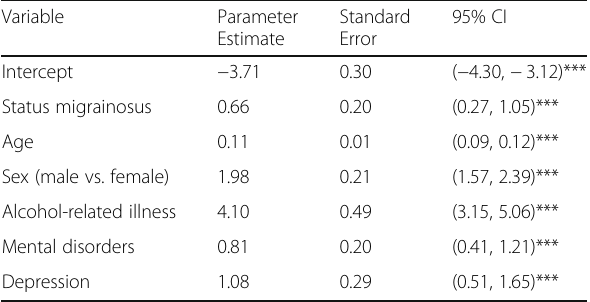
Table 4 Stepwise regression analysis for average hospital days per year (all-cause admission) among patients with migraine Variable Parameter Estimate